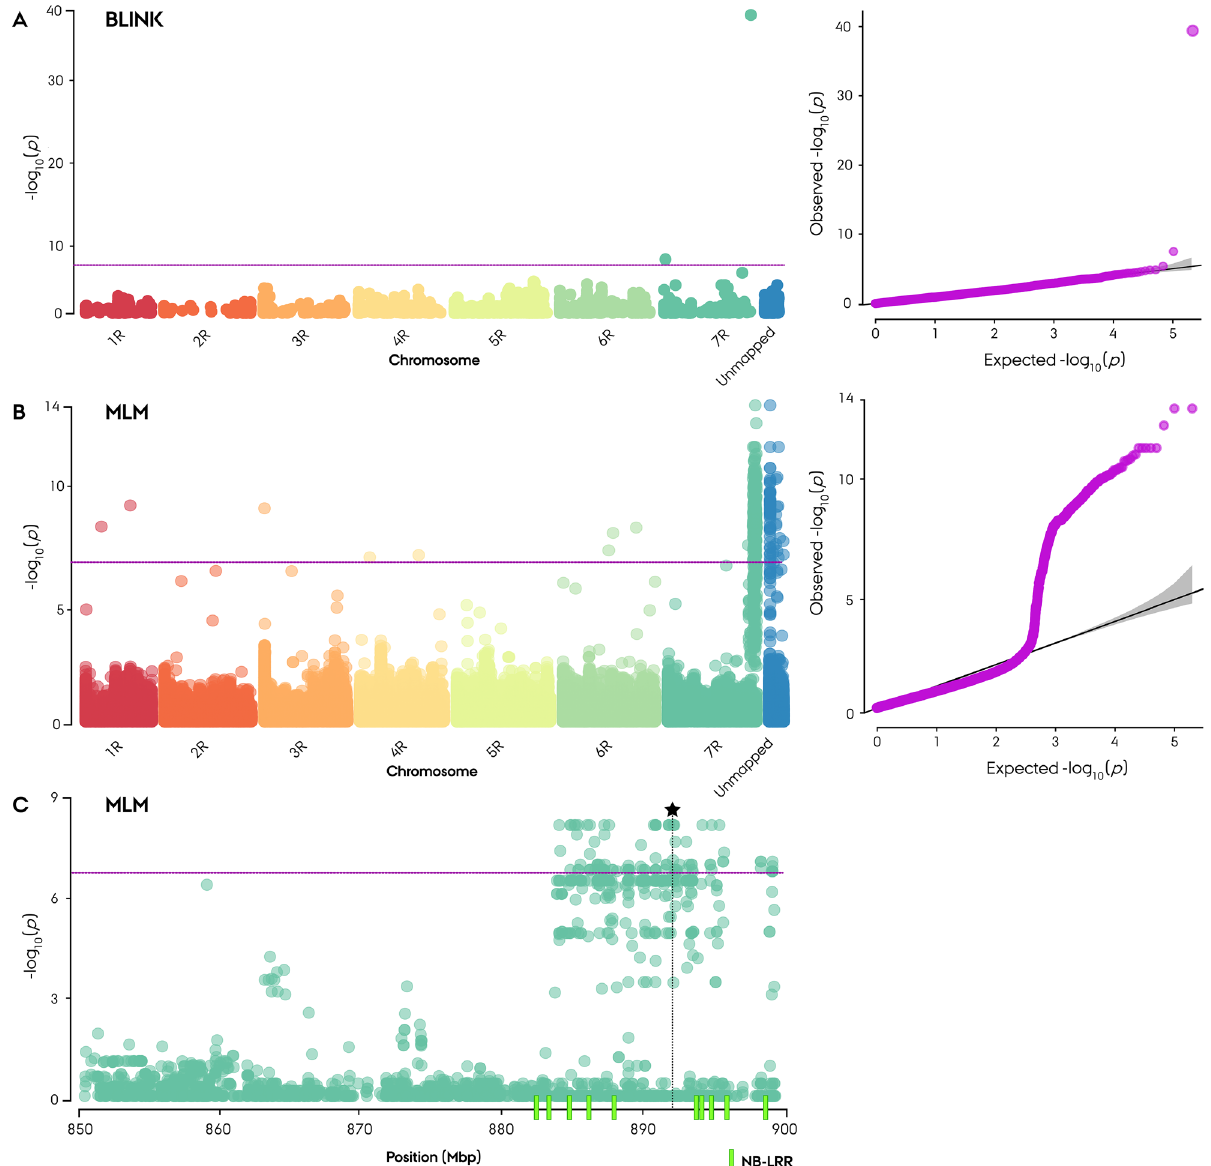
Figure 4. Manhattan plot for the genome-wide association study (GWAS) of powdery mildew disease resistance in Nordic Seed hybrid rye ( Secale cereale L.) elite breeding germplasm (n = 180) using 261,406 informative SNP markers. ( A ) GWAS using BLINK including a Q–Q plot. ( B ) GWAS using the MLM method including a Q–Q plot. ( C ) GWAS using the MLM method for the PM resistance-associated region on chromosome arm 7RL. Asterisks denote the position of the top-associated SNP marker identified in BLINK GWAS. NLR genes on the ‘Lo7’ reference genome are represented by green bars. The purple line represents the Bonferroni adjusted significance threshold based on informative